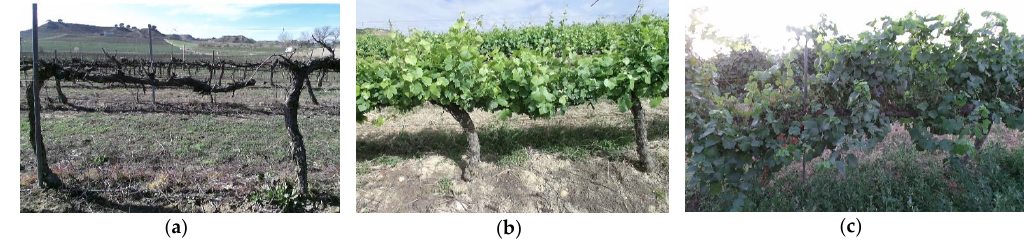
Figure 14. Condition of the vineyards used in the experiments conducted in: ( a ) February 2016; ( b ) May 2016; and ( c ) July 2016.